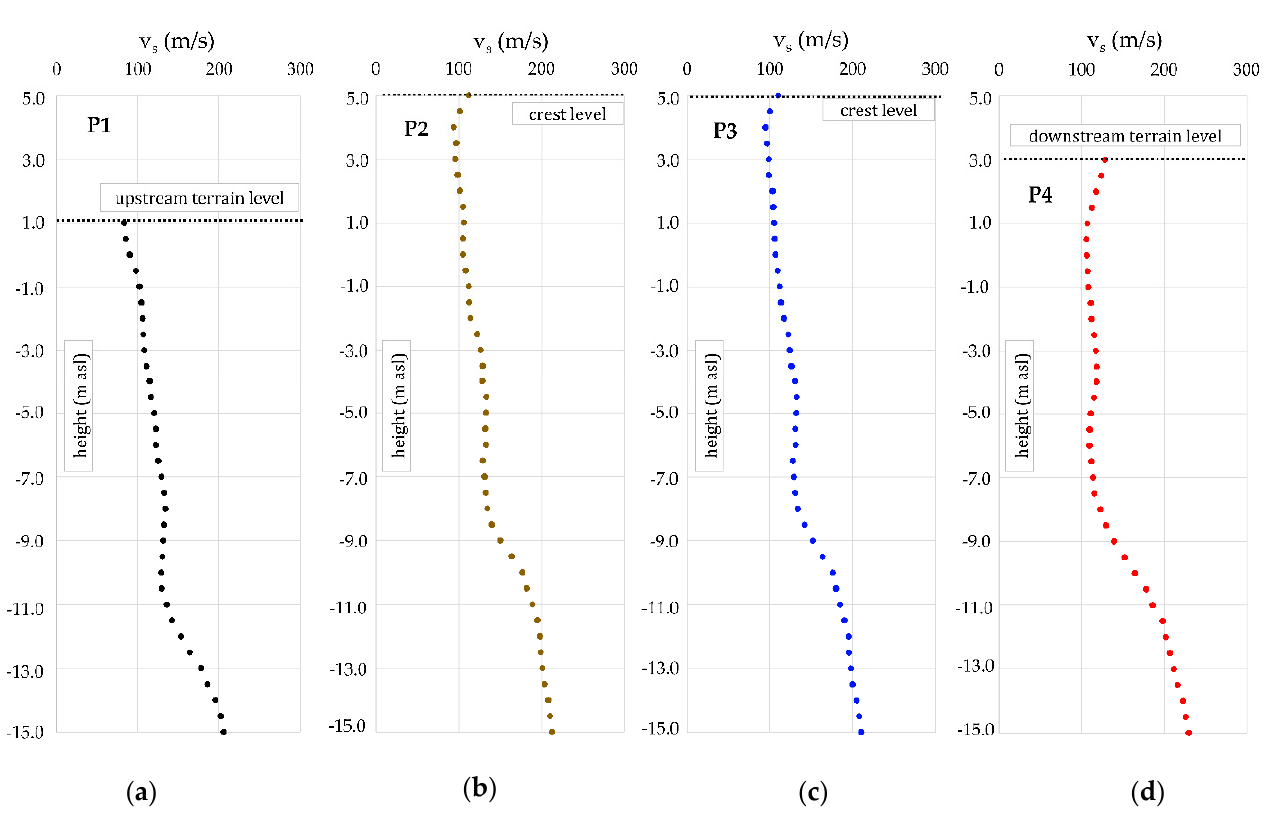
Figure 12. Values of 1D shear velocities from 4 investigation profiles: ( a ) P1 profile on the upstream side; ( b ) P2 on the crest; ( c ) P3 on the crest; ( d ) P4 on the downstream side.